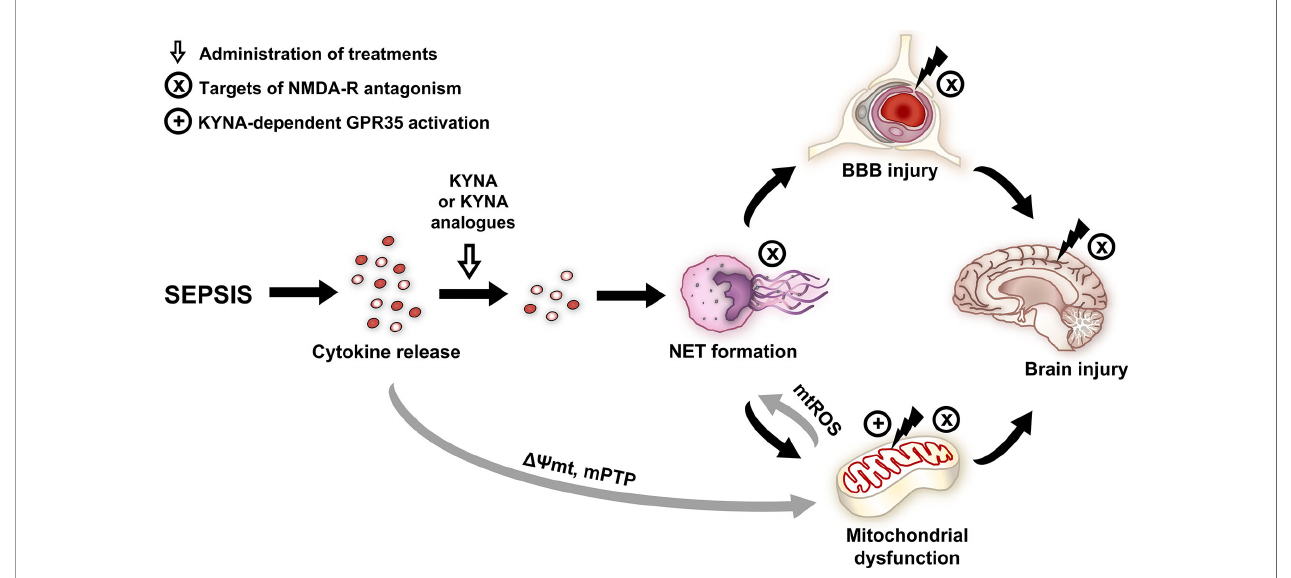
FIGURE 8 | Effects and potential targets of KYNA and its analogues. NMDA and GPR35 receptor-dependent mechanisms are highlighted. Gray arrows indicate the literature-based mechanisms, and black arrows indicate the mechanisms examined in the study. BBB, blood – brain barrier; GPR35, G protein-coupled receptor 35; KYNA, kynurenic acid; mPTP, mitochondrial permeability transition pore; mtROS, mitochondrial reactive oxygen species; NET, neutrophil extracellular trap; NMDA-R, N-methyl-D-aspartate receptor; DY mt, mitochondrial membrane